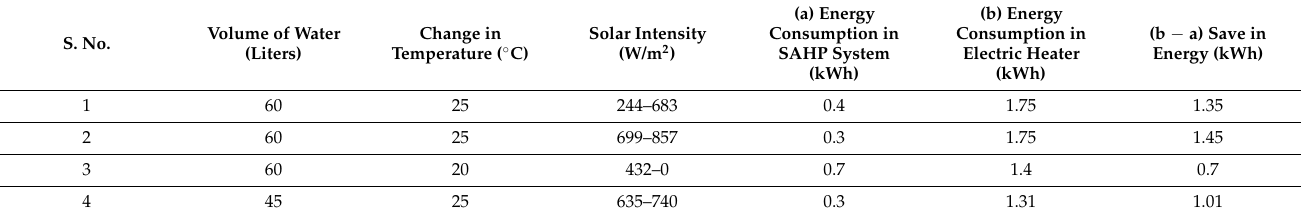
Table 10. Comparison of energy consumption of SAHP and electric